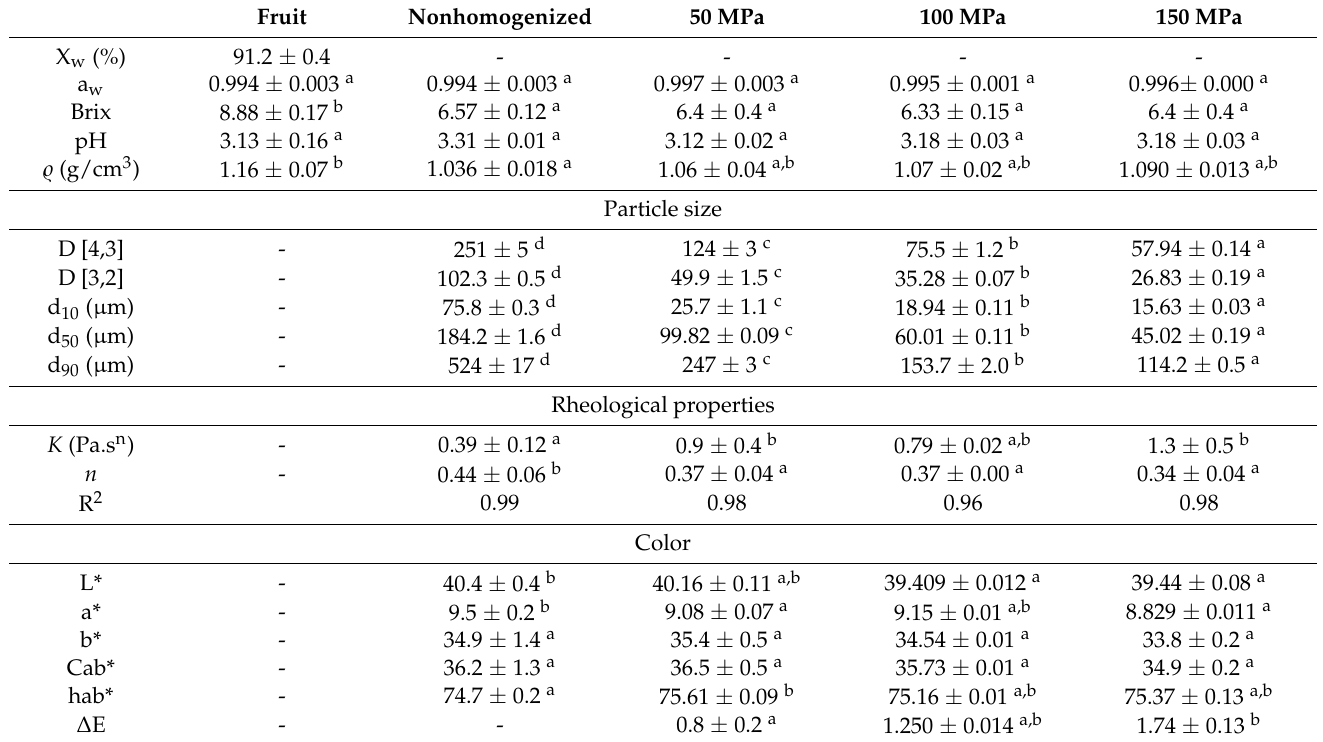
Table 2. Physicochemical characterization, water activity (a w ), moisture content (x w ), (g water/100 g), soluble solids, particle size, rheological properties, and CIE L*a*b* coordinates of the lulo fruit and homogenized and nonhomogenized juice. Mean ± standard deviation of three repetitions. (Different letters in superscripts mean significant differences ( p < 0.05)).